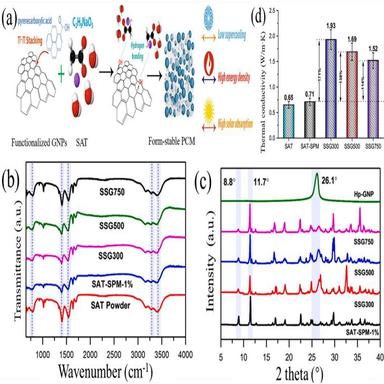
(a) schematic illustration of SAT-SPM/functionalized GNPs form-table hydrated salt PCMs synthesis, (b) FTIR spectra and (c) XRD patterns of SAT-SPM/ functionalized GNPs form-table hydrated salt PCMs, and (d) thermal conductivity at 30 ◦C of pure SAT, SAT-SPM and SAT-SPM/functionalized GNPs form-table hydrated salt PCMs Reproduced with the permission of Elsevier.